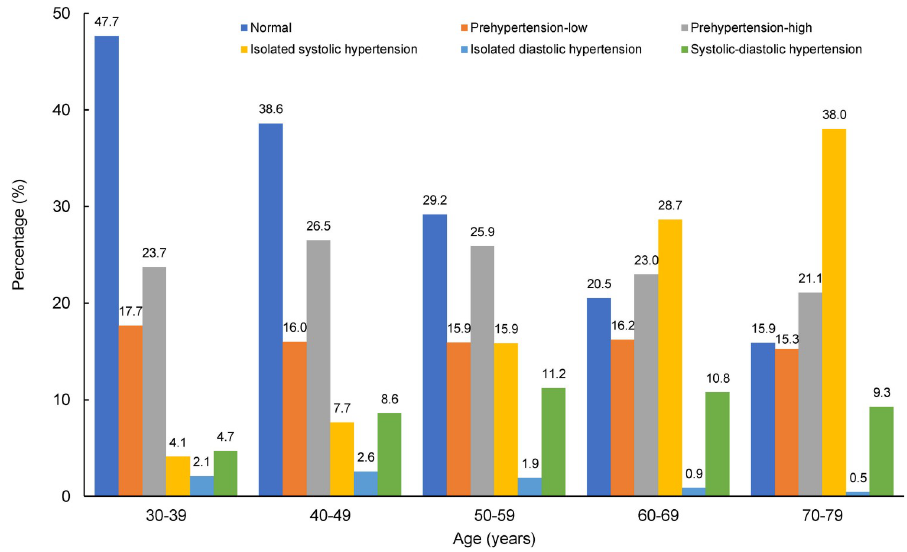
Fig 1. Percentages of blood pressure categories across different age